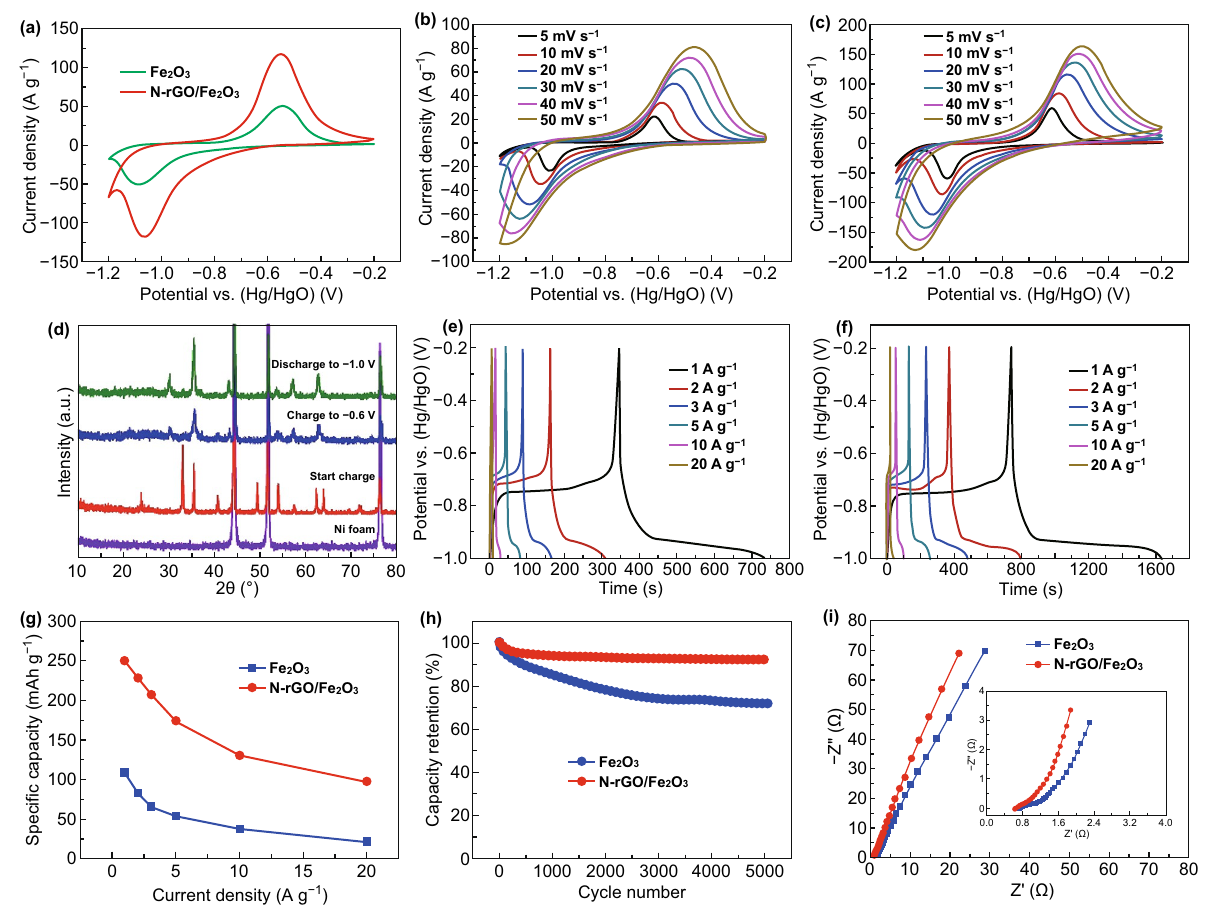
Fig. 7 a Comparison of CV curves of the pristine Fe 2 O 3 and N‑rGO/Fe 2 O 3 electrodes at 20 mV s −1 . CV curves at various scan rates of the b pristine Fe 2 O 3 and c N‑rGO/Fe 2 O 3 electrodes. d Ex‑situ XRD measurement of the N‑rGO/Fe 2 O 3 electrode during different electrochemical steps. GCD curves at various current densities of the e pristine Fe 2 O 3 and f N‑rGO/Fe 2 O 3 electrodes. g The rate performances, h cycling perfor‑ mances, and i EIS plots of the pristine Fe 2 O 3 and N‑rGO/Fe 2 O 3